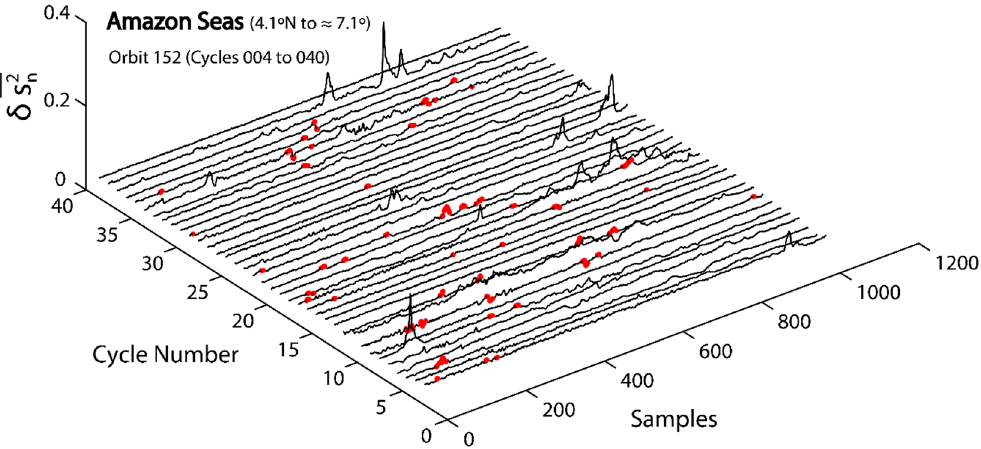
Figure 10. Graphic representation of a sequence of 37 cycles for relative orbit 152 of the Sentinel-3A SRAL for a stretch over more than 300 km off the Amazon shelf. The red segments indicate detection of ISWs by the algorithm in this paper. The along-track records comprise latitudes between 4.1 ° N to 7.1 ° N.